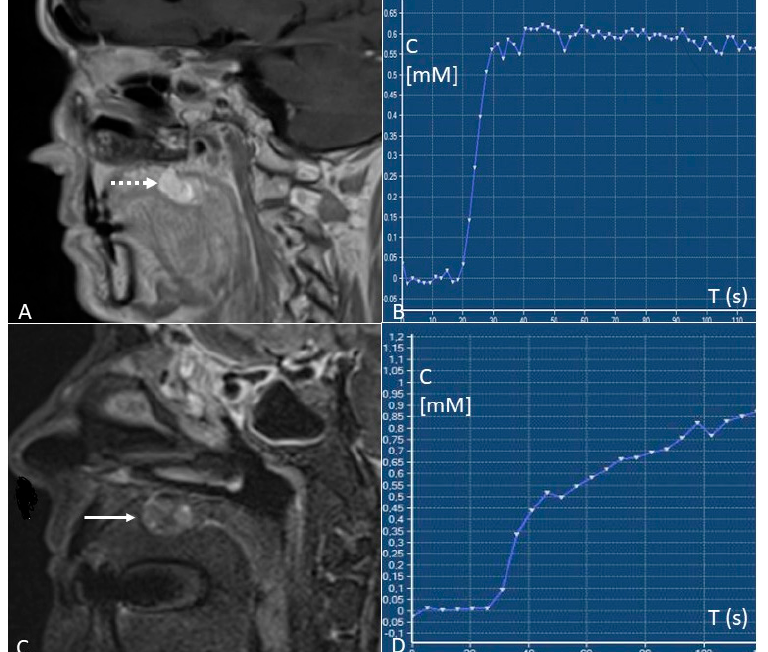
Figure 9. Malignant and benign lesions of the minor salivary glands of the palate. ( A ) Sagittal T1 contrast-enhanced image showing a polymorphous low-grade adenocarcinoma with vivid contrast enhancement (dotted arrow). ( B ) Time/intensity curve of dynamic contrast-enhanced perfusion weighted imaging. An early wash-in followed by a plateau is observed (Type C curve). C: concentration of contrast agent expressed in millimoles (mM). T: time (seconds). ( C ) Sagittal T2 fat-saturated image showing an unusual pleomorphic adenoma characterised by a low T2 signal intensity (arrow). ( D ) Time/intensity curve of dynamic contrast-enhanced perfusion weighted imaging. A progressive and slow enhancement is observed (Type A curve). C: concentration of contrast agent expressed in millimoles (mM). T: time